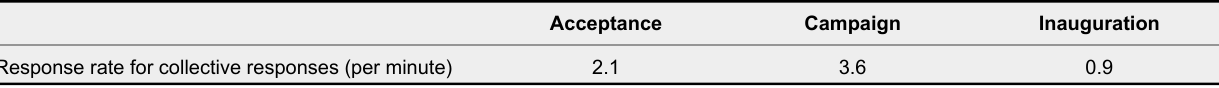
Collective Audience Response Rate by the Three Speech Contexts